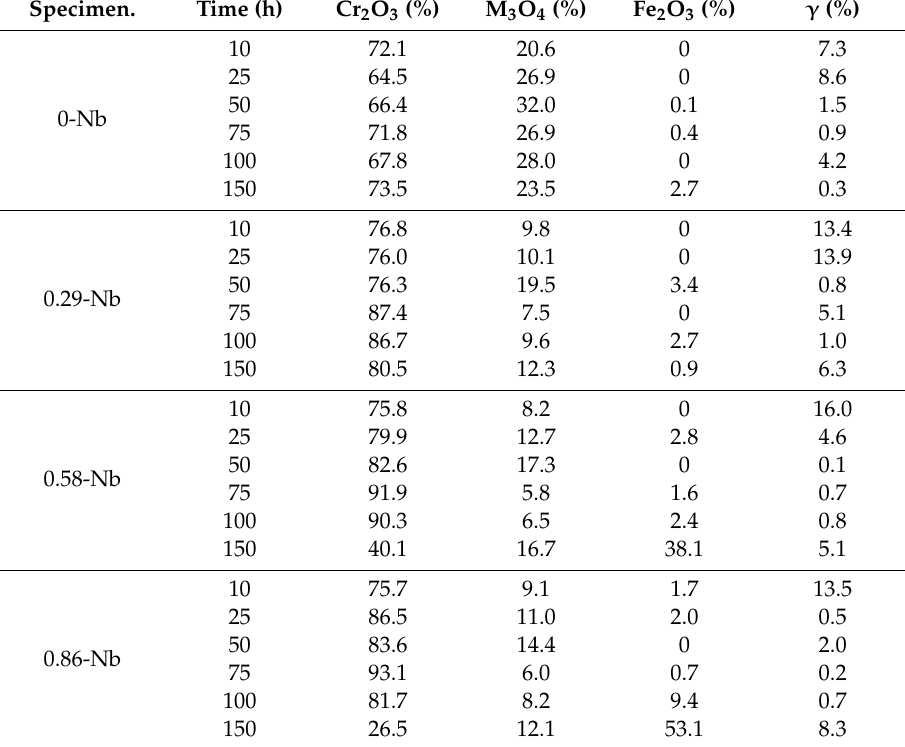
Table 4. Volume fractions of Cr 2 O 3 , M 3 O 4 , Fe 2 O 3 , and γ phases in 22Cr25NiWCoCu stainless steels with 0–0.86% Nb after oxidation in ambient air at 900 °C for an annealing time of 10–150 h obtained from grazing incidence X-ray using software TOPAS.